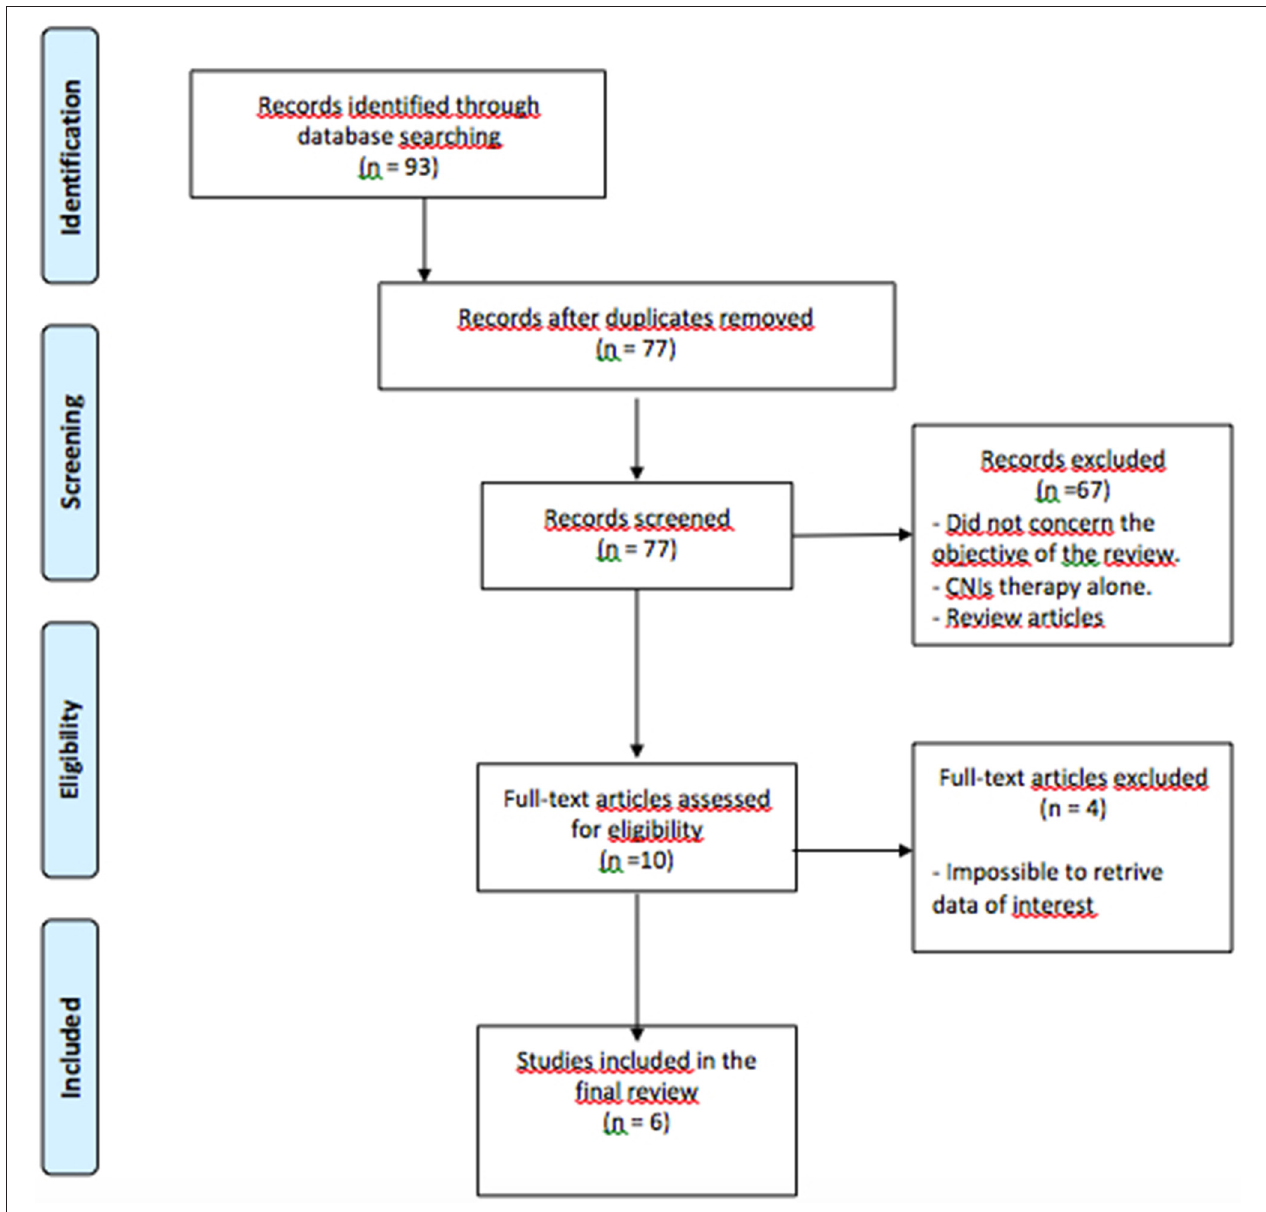
FIGURE 1 | Flow-chart of the review